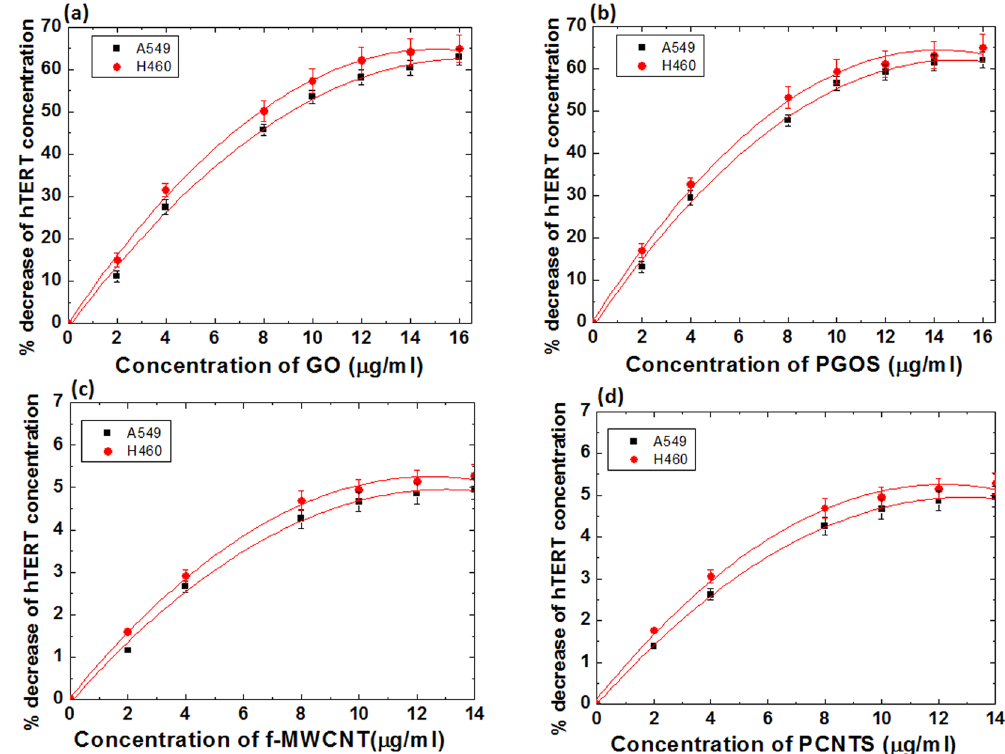
Figure 3. Percentage of decrease in hTERT concentration after ( a ) GO; ( b )PGOS; ( c )f-MWCNT and ( d ) PCNTS treatments on the A549 and H460 cancer